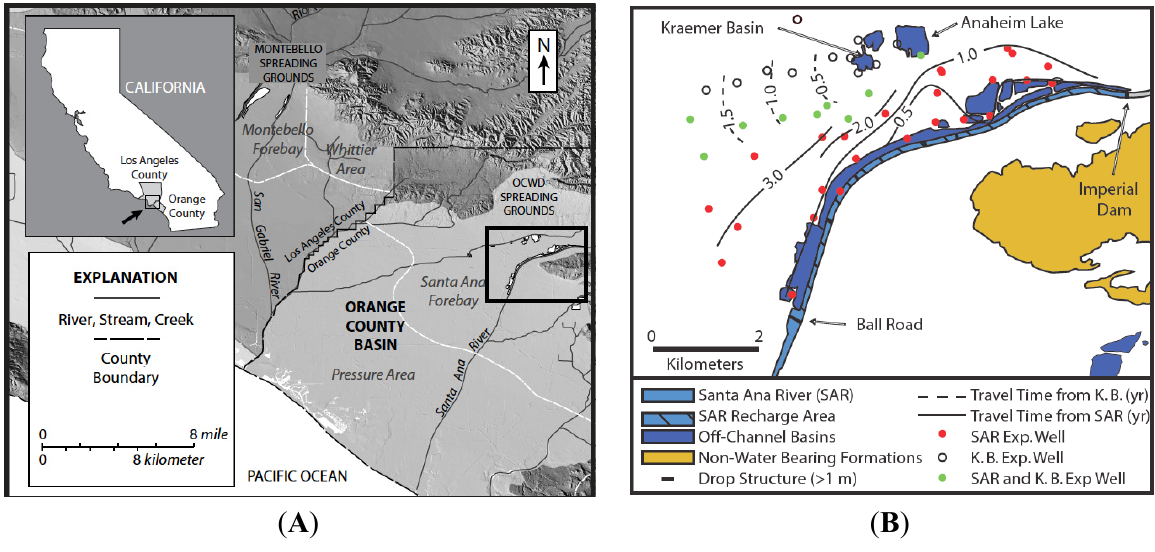
Figure 1. Maps of the Orange County managed aquifer recharge (MAR) facilities. ( A ) Topographic map of the field area including the location of Orange County Water District (OCWD) recharge basins based on data from the United States Geological Survey (USGS) 10-m National Elevation Dataset [32]; ( B ) Recharge occurs from the basins and from the Santa Ana River (SAR) between the Imperial Dam and Ball Road. The first arrival times of tracers determined in 1998 are contoured (modified from